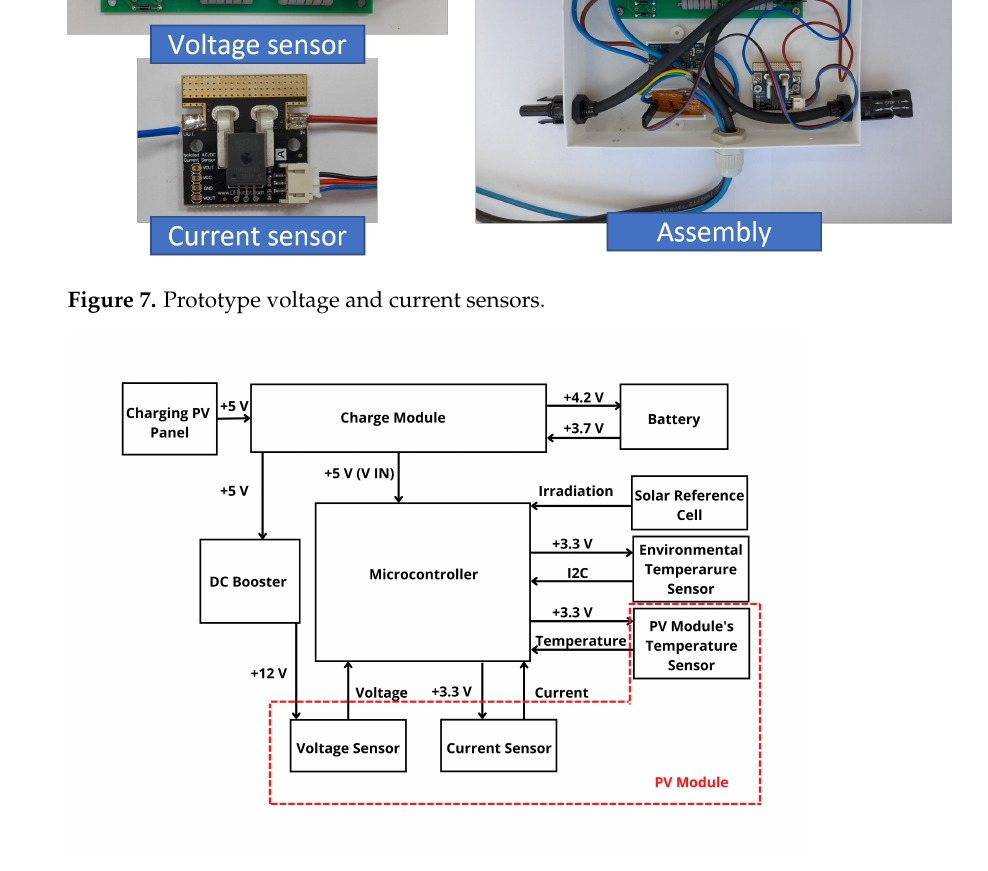
Figure 8. General scheme of the system electronics.